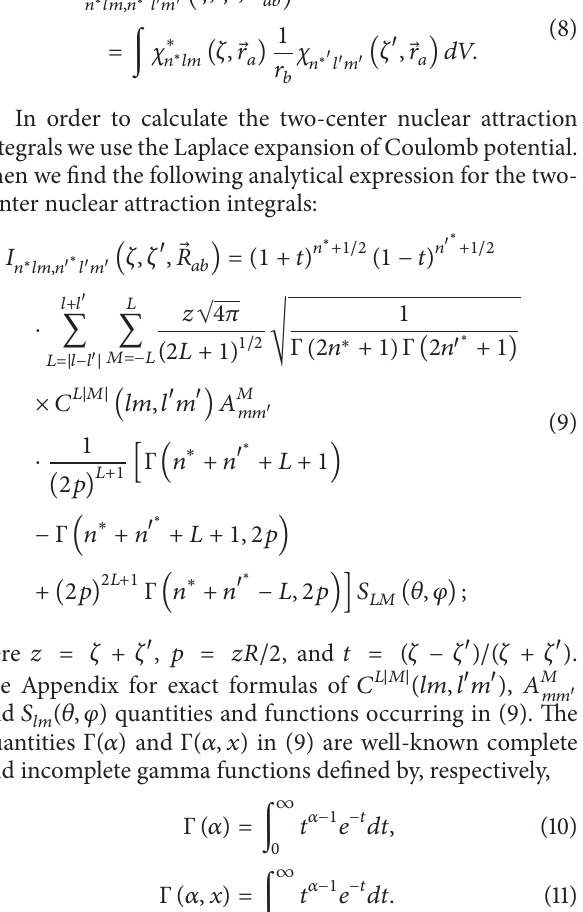
Table 2: Convergence of the series expansion relations for non- integer SF three-center nuclear attraction integrals over STOs as a function of summation limits for N . 𝑅 𝑎𝑐 = 1.8 , 𝜃 𝑎𝑐 = 30 , 𝜙 𝑎𝑐 = 60 , 𝑅 = 1.1 , 𝜃 = 60 , 𝜙 = 60 , and 𝛼 = 0 𝑎𝑏 𝑎𝑏 𝑎𝑏